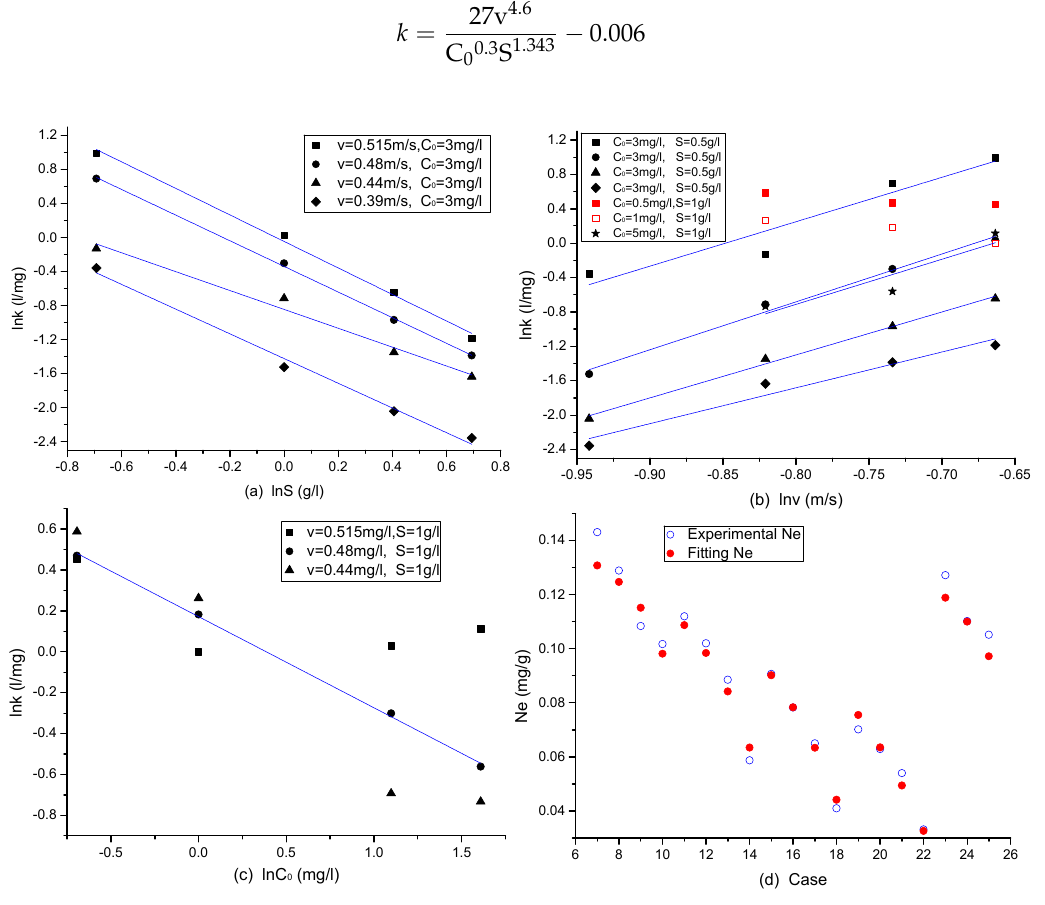
Figure 1. Relationships between k and S, v, C 0 ( a – c ) and the comparison between the fitting and experimental ratio Ne with cases 7–25 ( d ).